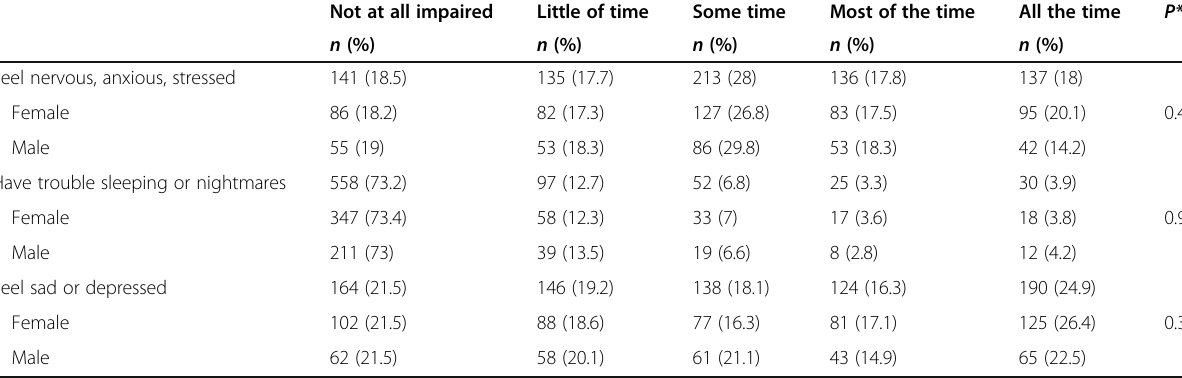
Table 3 Statistics of mental health symptoms associated with COVID-19 pandemic Not at all impaired Little of time Some